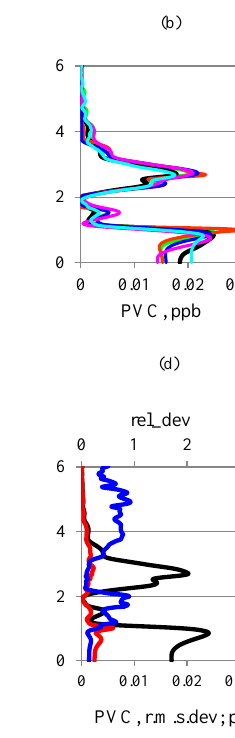
the same AERONET information, as well as their root mean square deviations and relative deviations for the two types of input data set, namely, with and without depolarization